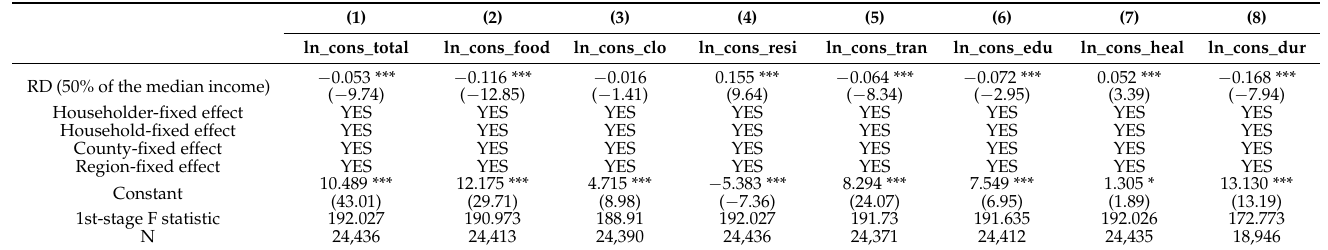
Table 4. Results of the robustness test (50% of the median income): IV model.